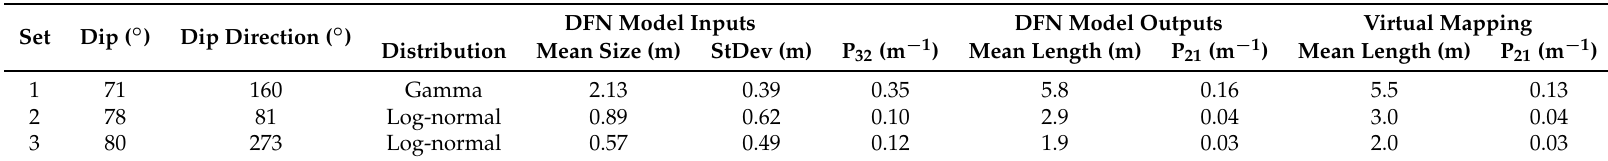
Table 4. Comparison of Mine B virtual mapping data and DFN model